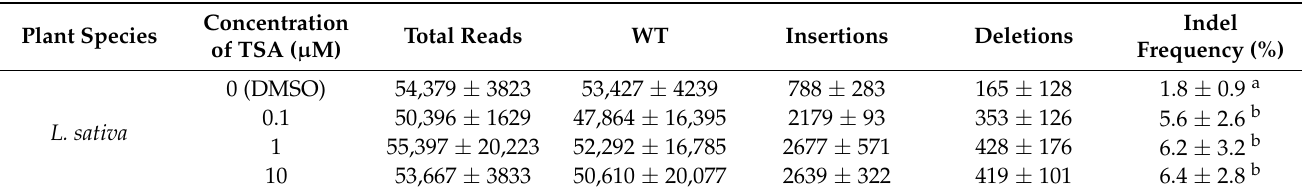
Table 1. Summary of the indel frequencies based on deep sequencing analysis of LsSOC1 target region from lettuce protoplasts. Each treatment consisted of three repeats, and average and standard deviation are represented. The superscripts in indel frequency indicate significant differences between each treatment (ANOVA with the Duncan’s test, p < 0.05). Plant